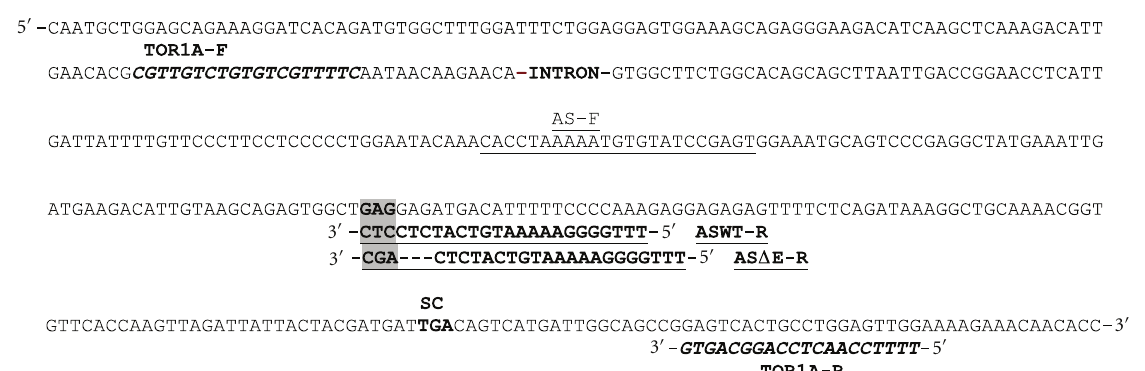
Figure 1: Primers used in allele-specific PCR assays: partial sequence of the 4th and 5th exons of human torsinA is shown and their intronic sequence is indicated by “-INTRON-.” The primer pair (TOR1A-F and TOR1A-R) used to generate a 327bp human TOR1A fragment from RNA is shown in bold italics. The allele-specific pairs of primers used to discriminate between the WT and Δ E TOR1A alleles are underlined. The same allele-specific forward primer is used (AS-F) with two di ff erent reverse primers, one matching the WT allele with 3 (cid:3) ending at CTCCTC (ASWT-R) and the other matching the mutant allele, missing a 303 bp-GAG and thus with a 3 (cid:3) ending at CGACTC (AS Δ E-R). The last three nucleotides, which are di ff erent between the two reverse primers, are highlighted in grey; the dashes represent the 3 nucleotides deleted in the AS Δ E-R primer. The stop codon (SC) TGA is also indicated in bold. All reverse primers are shown under their corresponding forward sequence in reverse complement